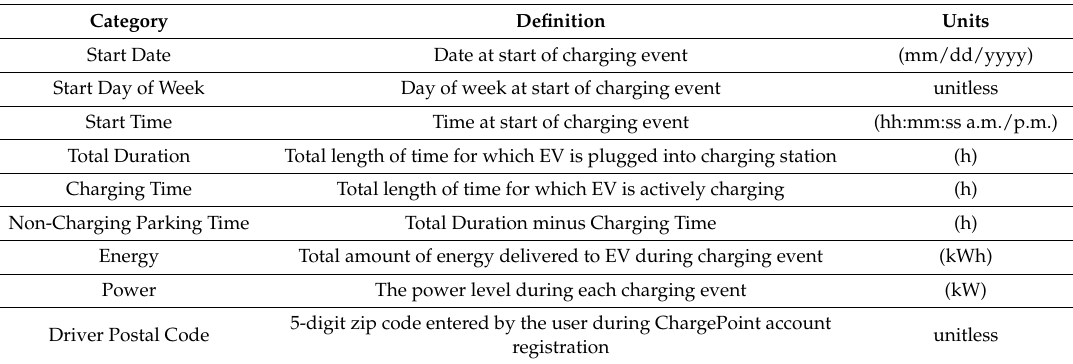
Table 1. Information obtained from raw